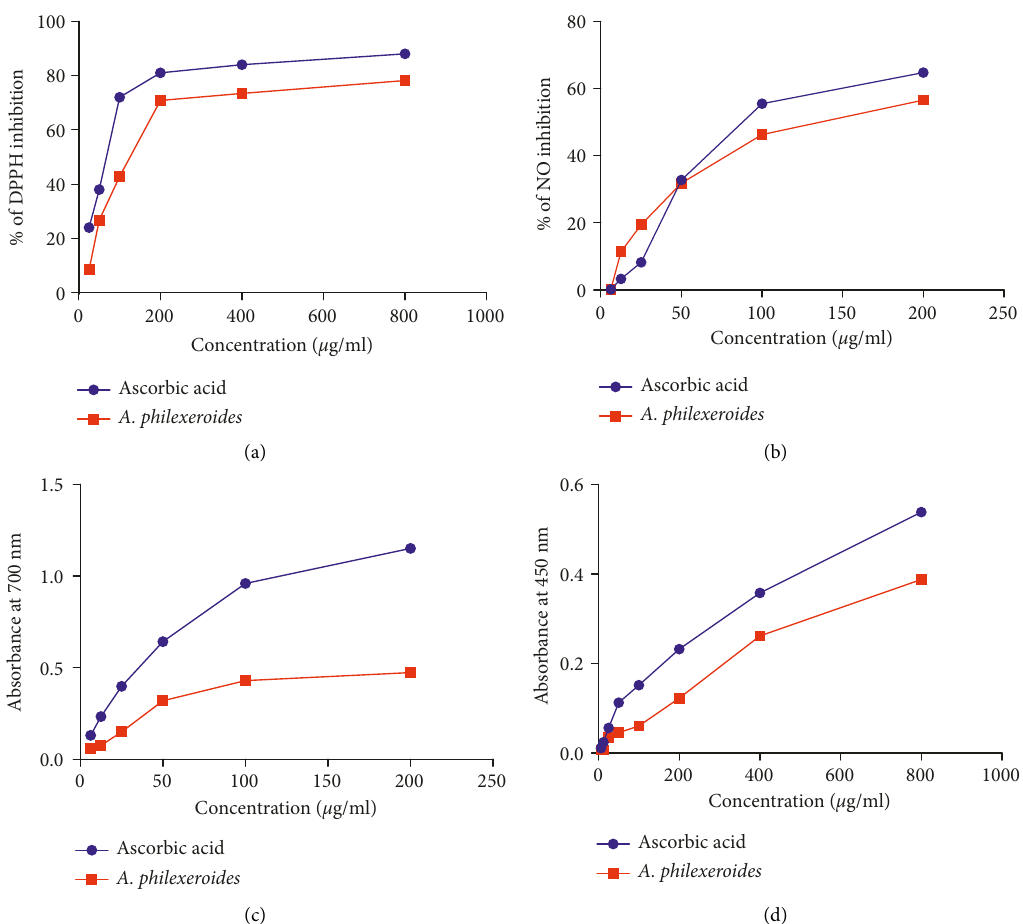
Figure 2: This figure shows (a) DPPH free radical scavenging activity, (b) NO free radical scavenging activity, (c) reducing power capacity, and (d) cupric reducing antioxidant capacity of the methanolic extract of A. philoxeroides . Table 3: Anticoagulant activities of A. philoxeroides extract (PT and aPTT). Clotting time in the presence of A. philoxeroides extract at Anticoagulant test Control clotting time